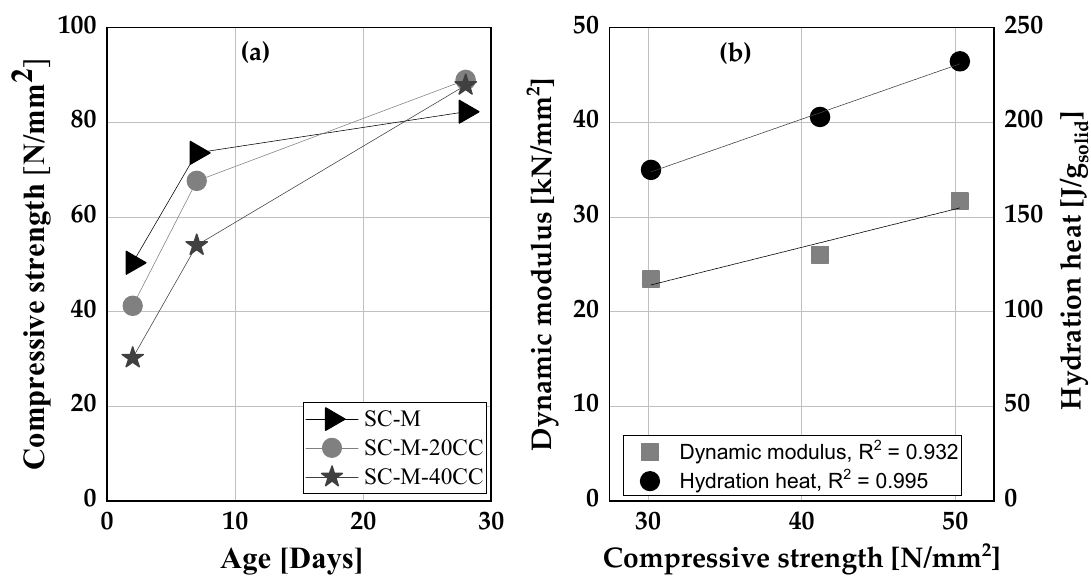
Figure 14. ( a ) Compressive strength development of SC-M specimens, ( b ) Correlation between the compressive strength at 2 days with dynamic modulus and hydration heat at 2 days of hydration.